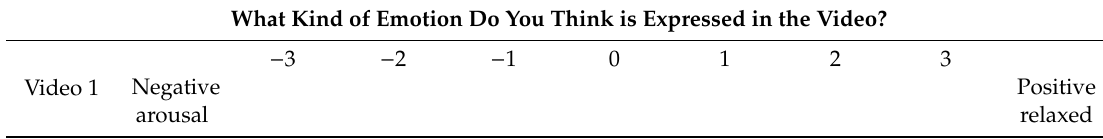
Table 1. Questionnaire style and content of a video